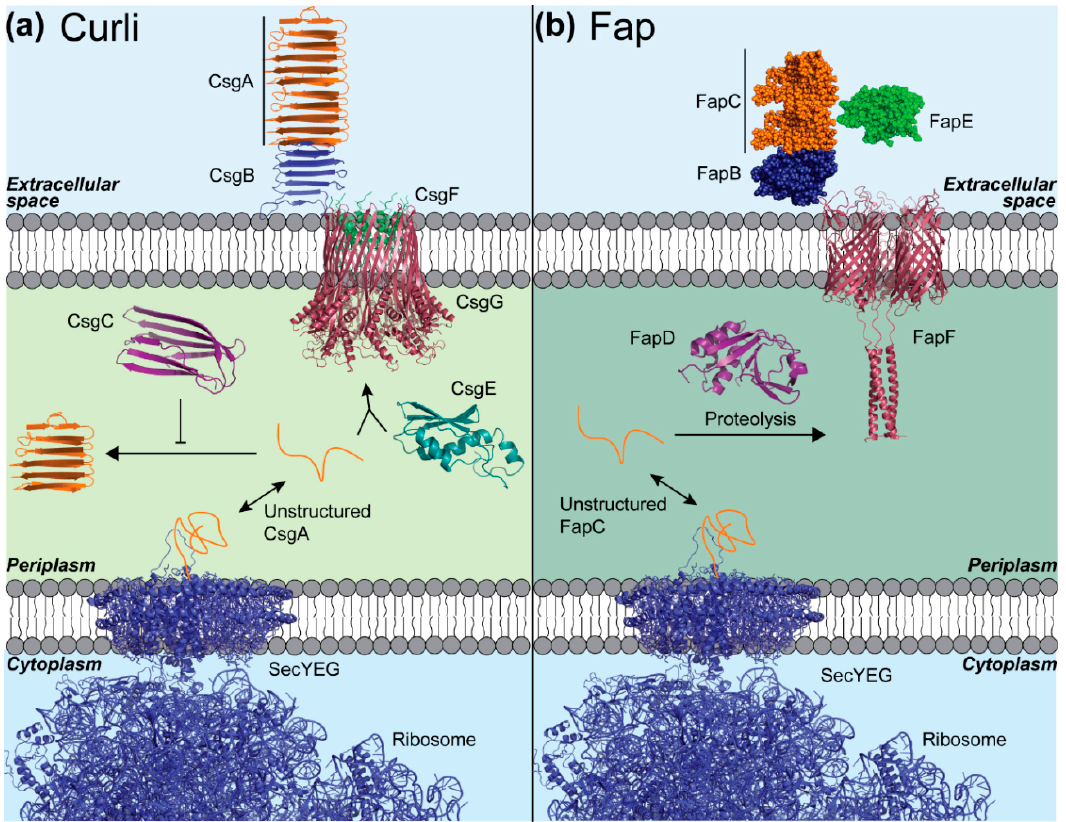
Figure 3. The bacterial amyloid systems called curli in E. coli and fap in P. aeruginosa are controlled through complex, multi-protein mechanisms. ( a ) The curli operon contains 7 proteins (6 shown here), each playing a necessary role in maintaining spatiotemporal control over polymerization of the major curli subunit CsgA [72]. CsgA is translated and translocated directly into the periplasm using the SecYEG secretion pore (PDB: 4V6M). CsgC (PDB: 2y2y) is a chaperone-like protein which inhibits CsgA aggregation within the periplasm. CsgE (PDB: 2NA4) is another periplasmic chaperone which fosters CsgA translocation through the nonameric curli assembly pore CsgG (PDB: 6L7A). Lastly, CsgF (PDB: 6L7A) and CsgB (REF [73]) both help to localize curli formation to the CsgG pore and the outer membrane, respectively. ( b ) In Pseudomonas , the major fap component FapC, is secreted into the periplasm using a SecYEG pore. FapD (modeled after the homologous C39 peptidase domain of ABC transporter PCAT1, PDB: 4RY2) is a peptidase which performs an essential proteolytic modification to one or more of the fap proteins. FapC is passed through the outer membrane using FapF, a trimeric polypeptide transporter (PDB: 5O67). Finally, FapB and FapE are essential minor components of fap amyloids, with FapB potentially playing a nucleator role similar to CsgB. Models shown of FapC, FapB, and FapE are structural predictions produced by the FALCON@home server, since there is no putative structural data in the literature.